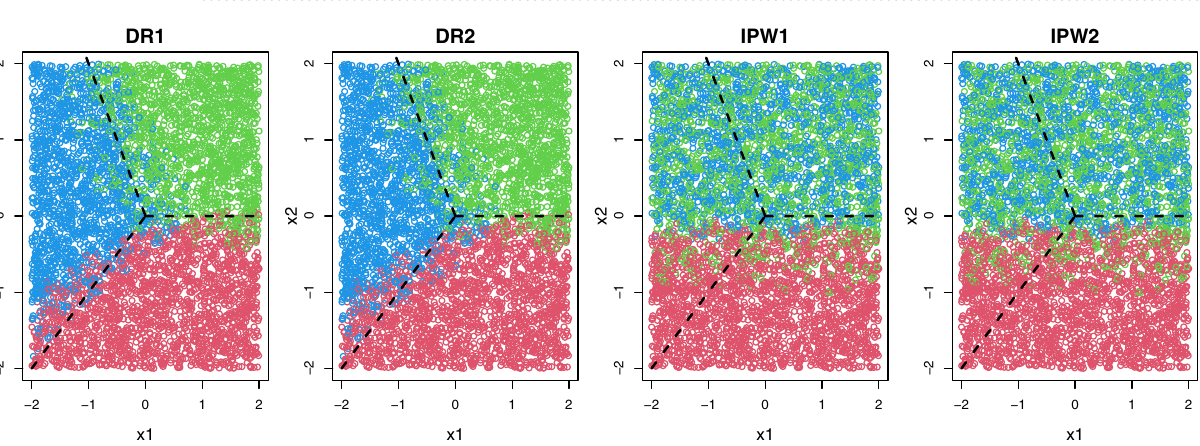
Figure 2. Cumulative incidence rate and average correct decision rate (ACDR) of two stages under optimal dynamic treatment regimes with OWL, DWL, POWL and PDWL for different sample sizes. Optimal regimes should minimize the cumulative incidence rate but maximize ACDR.